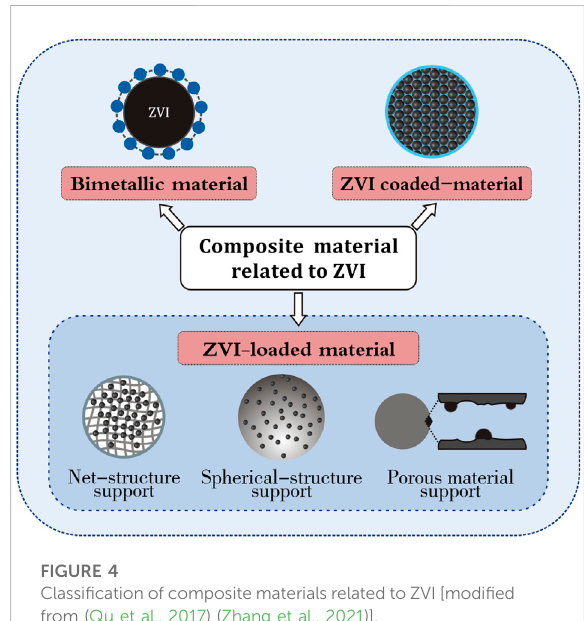
FIGURE 4 Classi fi cation of composite materials related to ZVI [modi fi ed from (Qu et al., 2017) (Zhang et al.,